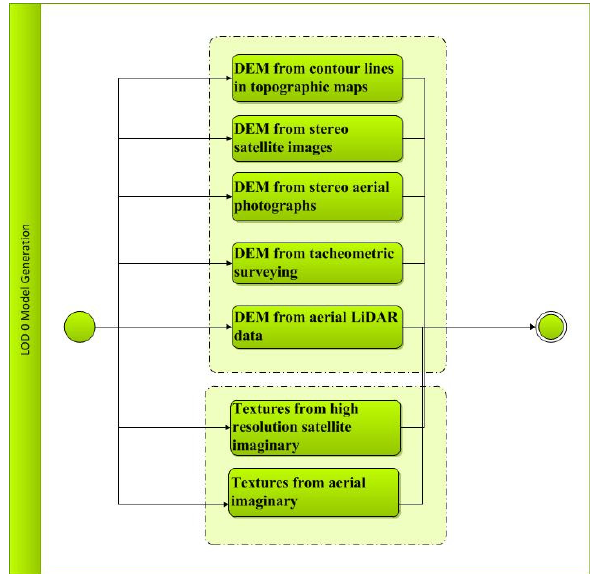
Figure 2 . LOD 0 Model generation